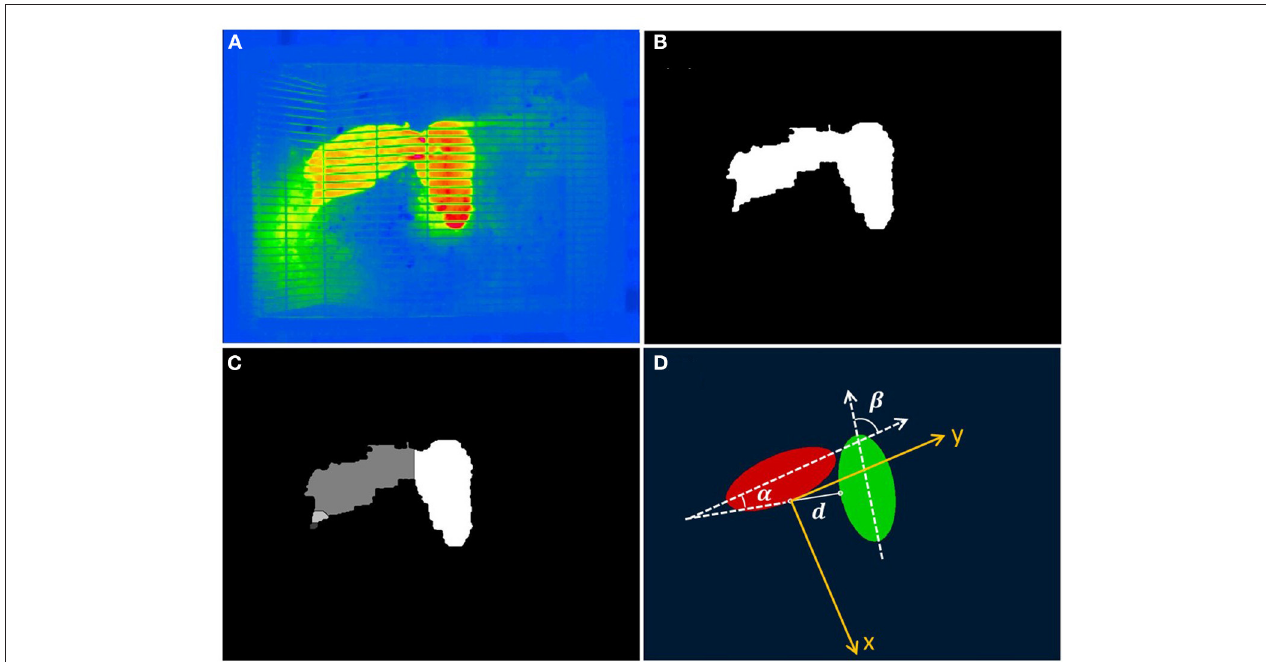
FIGURE 1 | Image processing procedure of identifying images of the two rats. (A) A raw thermography. (B) The binarized image of (A) . (C) A segmented image of the two rats with pixels belonging to the different rats shown in different grayscale. (D) Representing the positions and orientations of the two rats using two ellipses. The coordinate system and definitions of the relative distances, directions, and orientations are